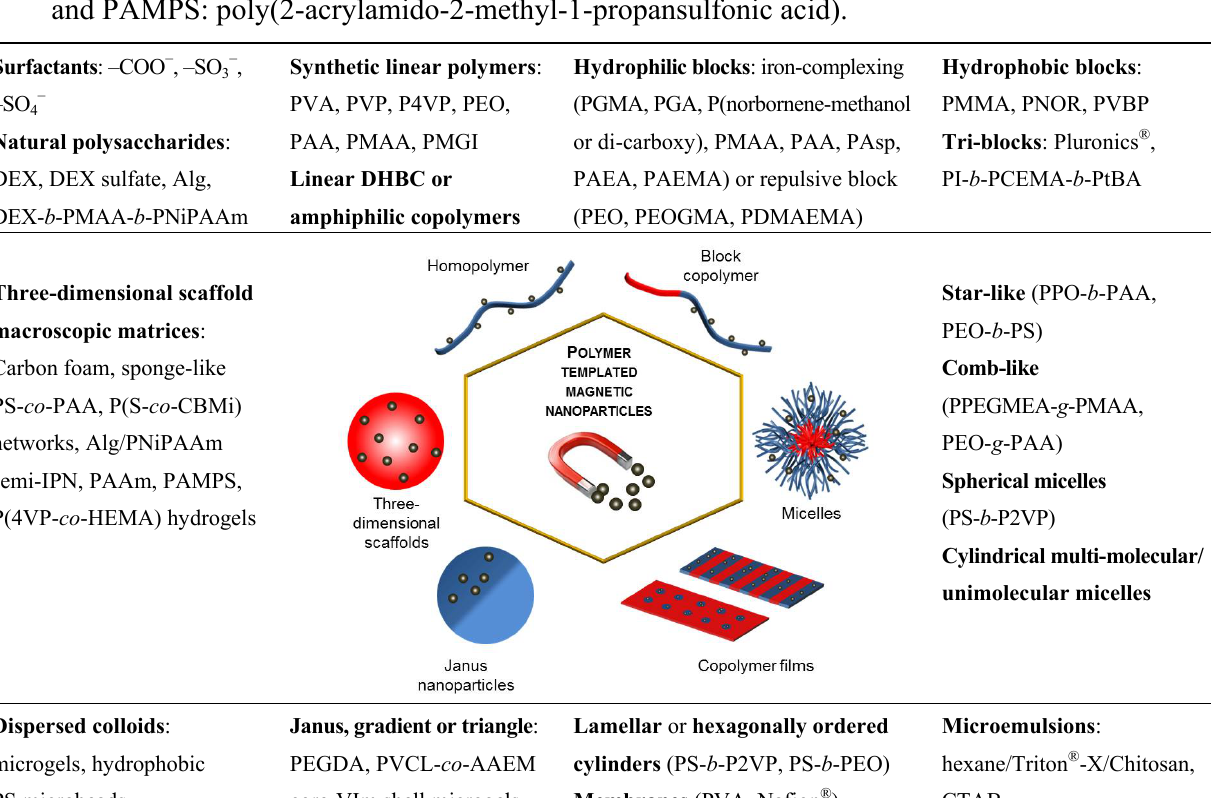
Table 5. Summary of the different organic templates used as host matrices for the synthesis of MNPs. In this review, the examples gathered from the literature were sorted according to their chemical nature and structural properties (e.g., geometry, dimensionality,